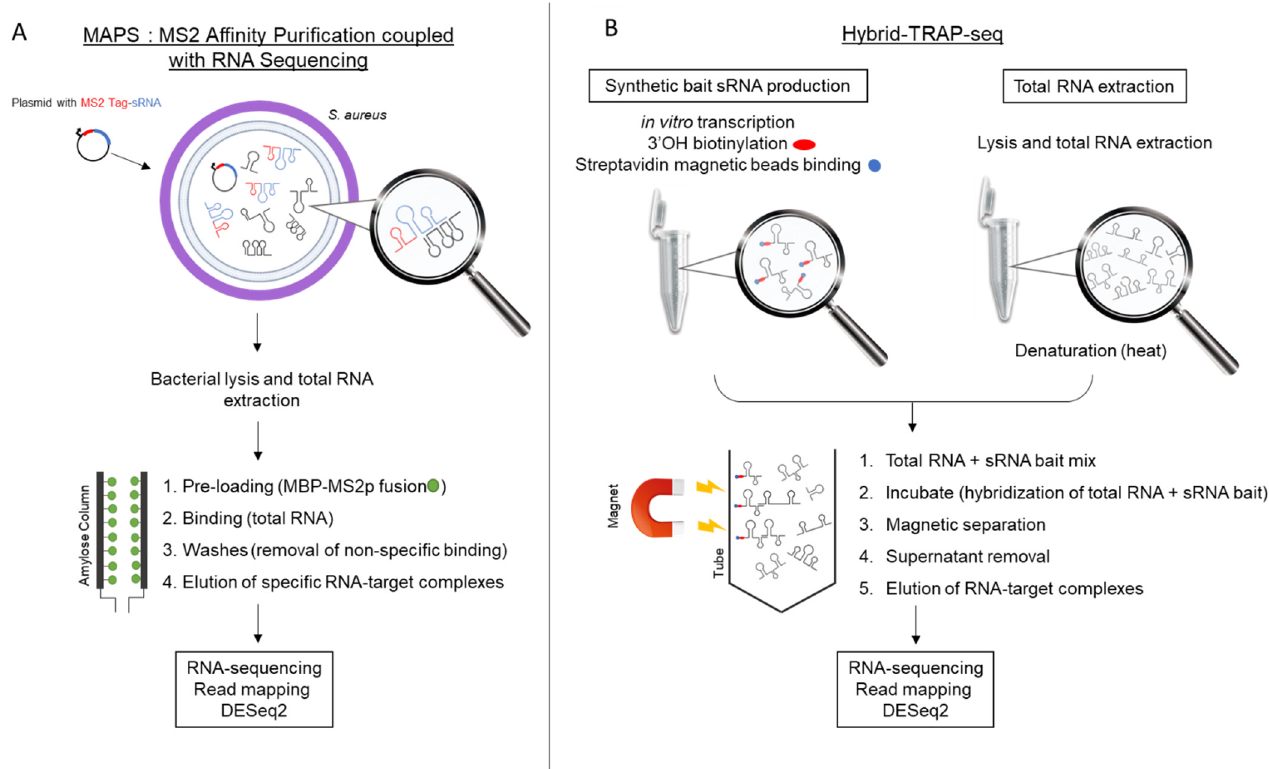
Figure 3. Experimental high-throughput techniques to identify an sRNA interactome in S. aureus : ( A ) MAPS (MS2-affinity purification coupled with RNA sequencing) protocol. Green dots: MBP (maltose-binding protein) in fusion with MS2p (MS2 protein); ( B ) Hybrid-trap-seq protocol. Red ovals: biotinylation in the 3 ′ OH end of bait sRNA. Blue dots: streptavidin magnetic beads bound to the biotinylate 3 ′ OH ends of bait sRNA.